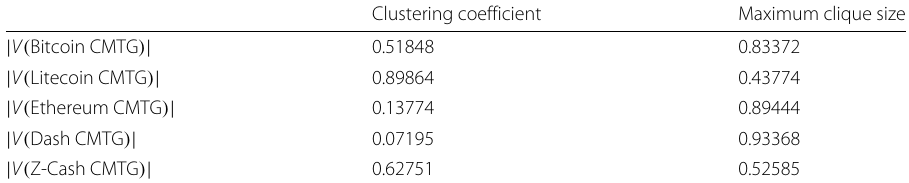
Table 6 Correlation of maximum clique size and clustering coefficient with the number of nodes in CMTG Clustering coefficient Maximum clique size | V ( Bitcoin CMTG ) |